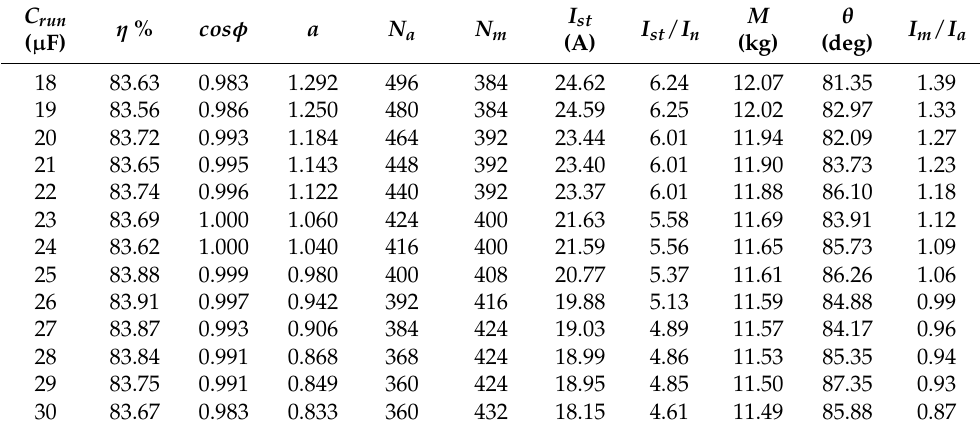
Table 5. Design parameters and performance quantities of the SPIMs with rotor bars of pent